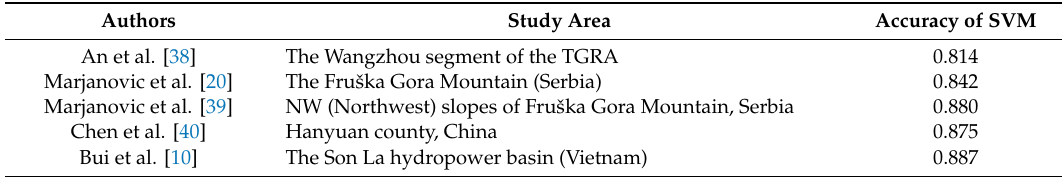
Table 9. The accuracy of SVM model in di ff erent